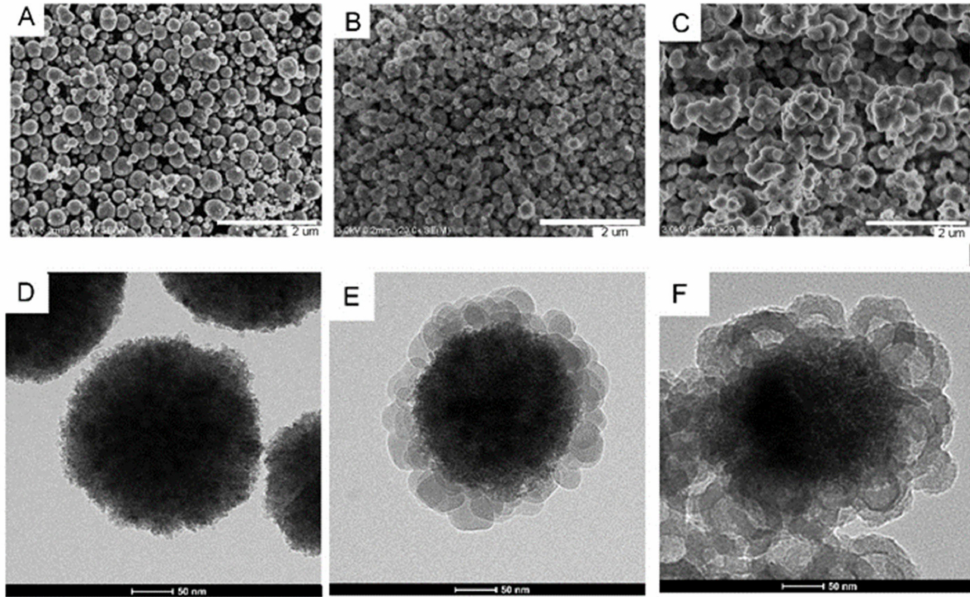
Figure 1. SEM images of Fe 3 O 4 ( A ), Fe 3 O 4 @ZIF-8 ( B ), and Fe 3 O 4 @ZIF-8@MIP ( C ); TEM images of Fe 3 O 4 ( D ), Fe 3 O 4 @ZIF-8 ( E ), and Fe 3 O 4 @ZIF-8@MIP ( F